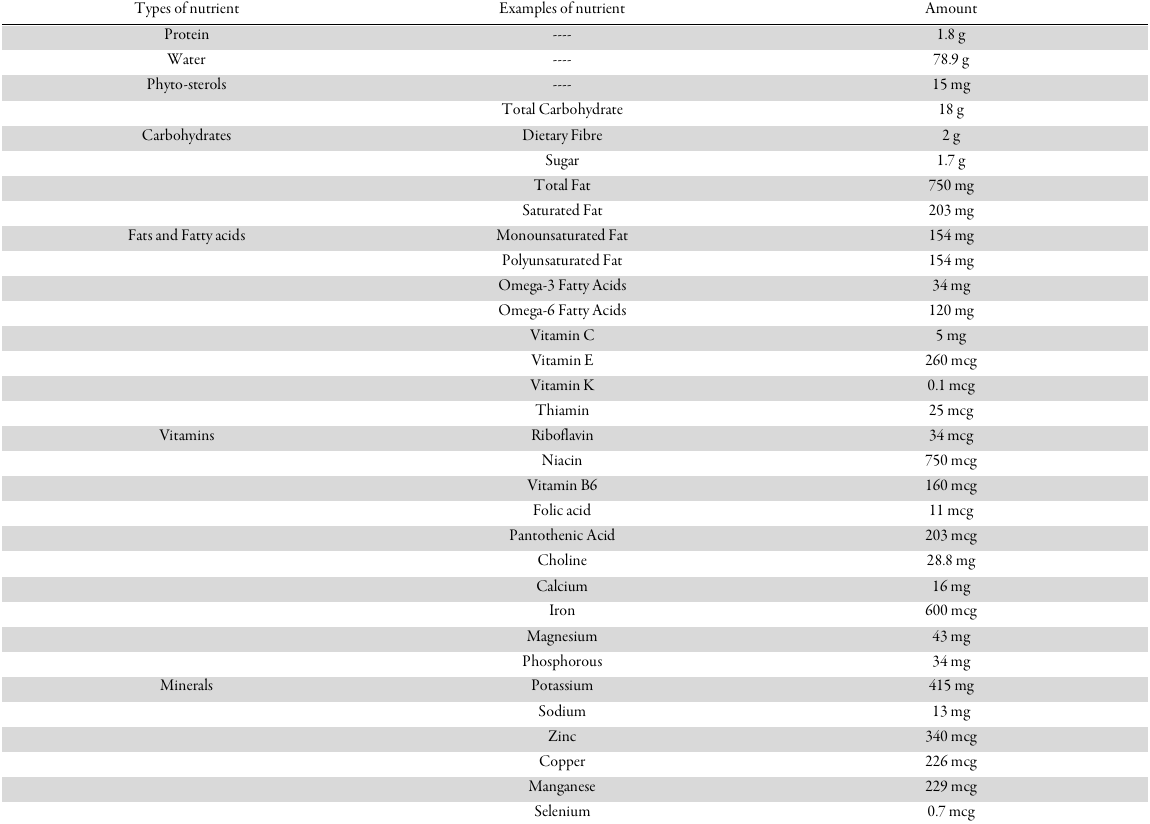
Table 3. Nutritional profile of Ginger (100 g) (Singh et al ., 2017)